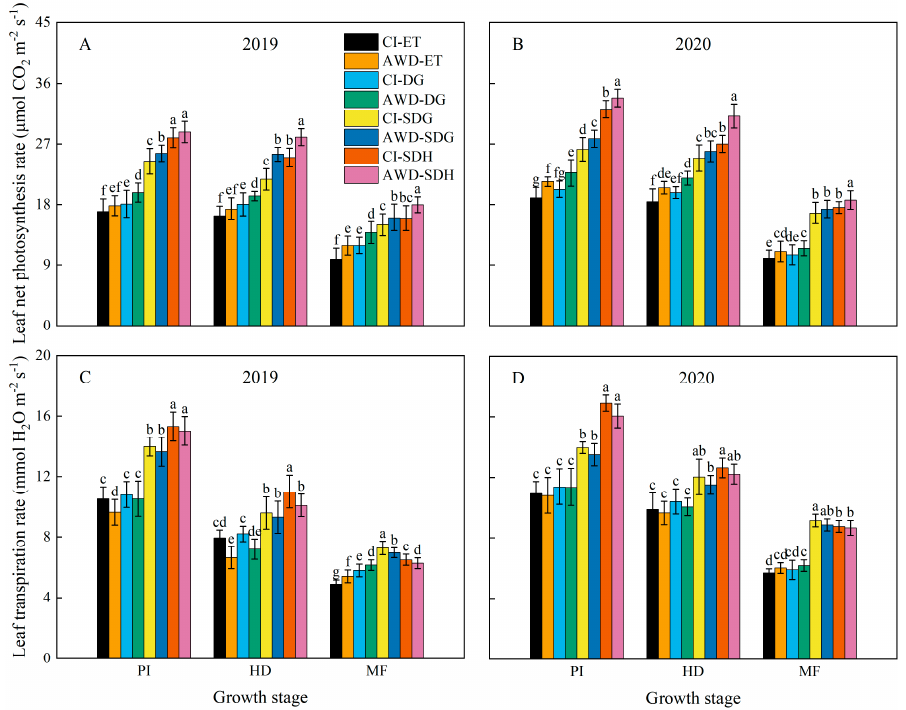
Figure 3. Flag leaf net photosynthetic rate ( A , B ) and transpiration rate ( C , D ) at three growth stages of mid-season indica rice genotypes under different irrigation treatments. CI and AWD represent conventional irrigation treatment and alternate wetting and drying irrigation treatments, respectively. ET denotes early tall genotype, DG denotes dwarf genotype, SDG denotes semi-dwarf genotype, and SDH denotes semi-dwarf hybrid. PI, HD, and MF present panicle initiation, heading, and middle grain filling stage, respectively. Vertical bars represent ± standard error of the mean where these exceed the size of the symbol. Different letters above the columns indicate significant differences ( p ≤ 0.05) within the same measurement time.